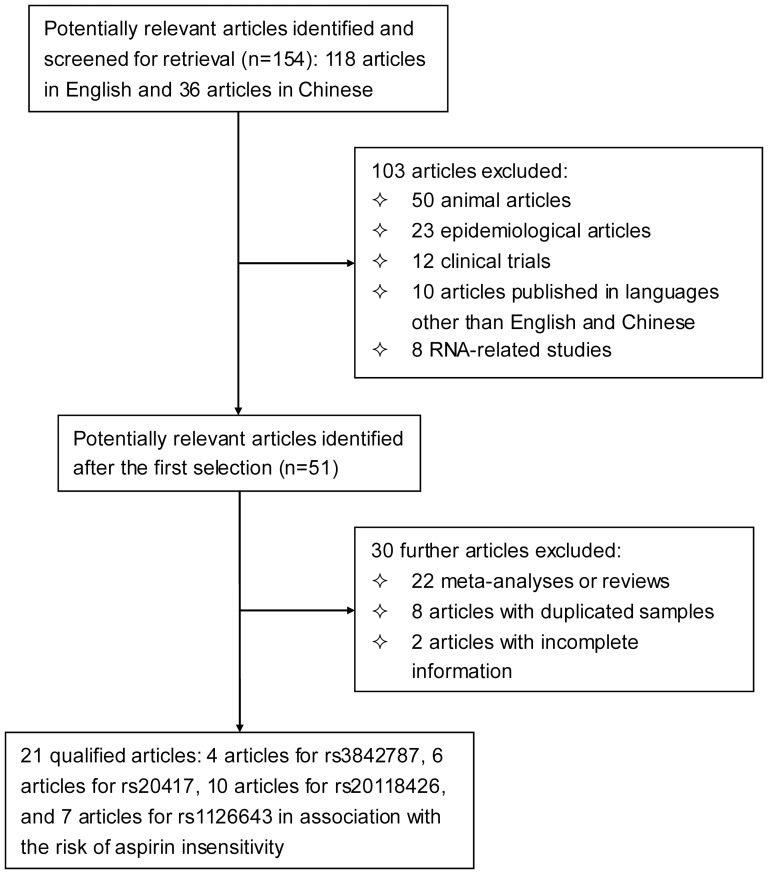
Flow diagram of search strategy and study selection.